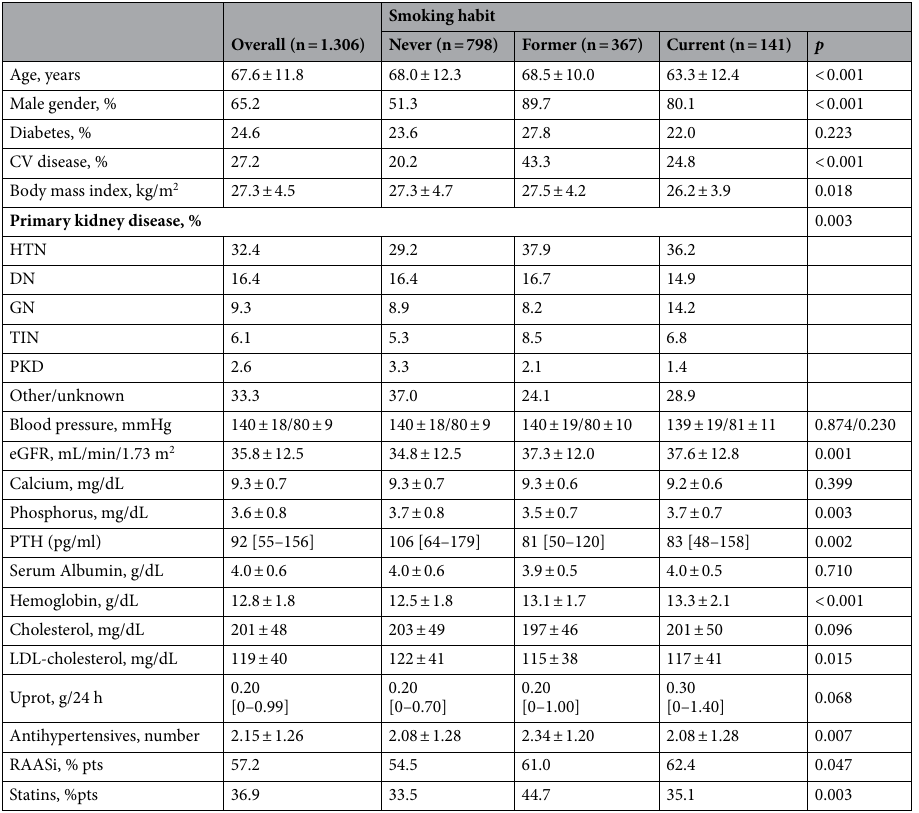
Table 1. Basal characteristics of patients overall and by smoking habit (never, former, current). CV cardiovascular, HTN hypertensive nephropathy, DN diabetic nephropathy, GN glomerulonephritis, TIN tubulointerstitial nephropathies, PKD polycystic kidney disease, PTH parathyroid hormone, LDL low-density lipoprotein, RAASi renin–angiotensin–aldosterone-system